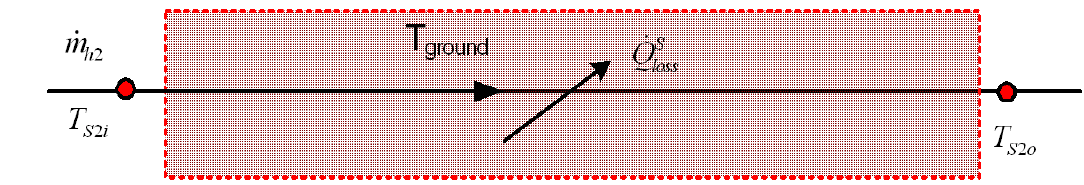
Figure 12. Heat loss model of supply water line.